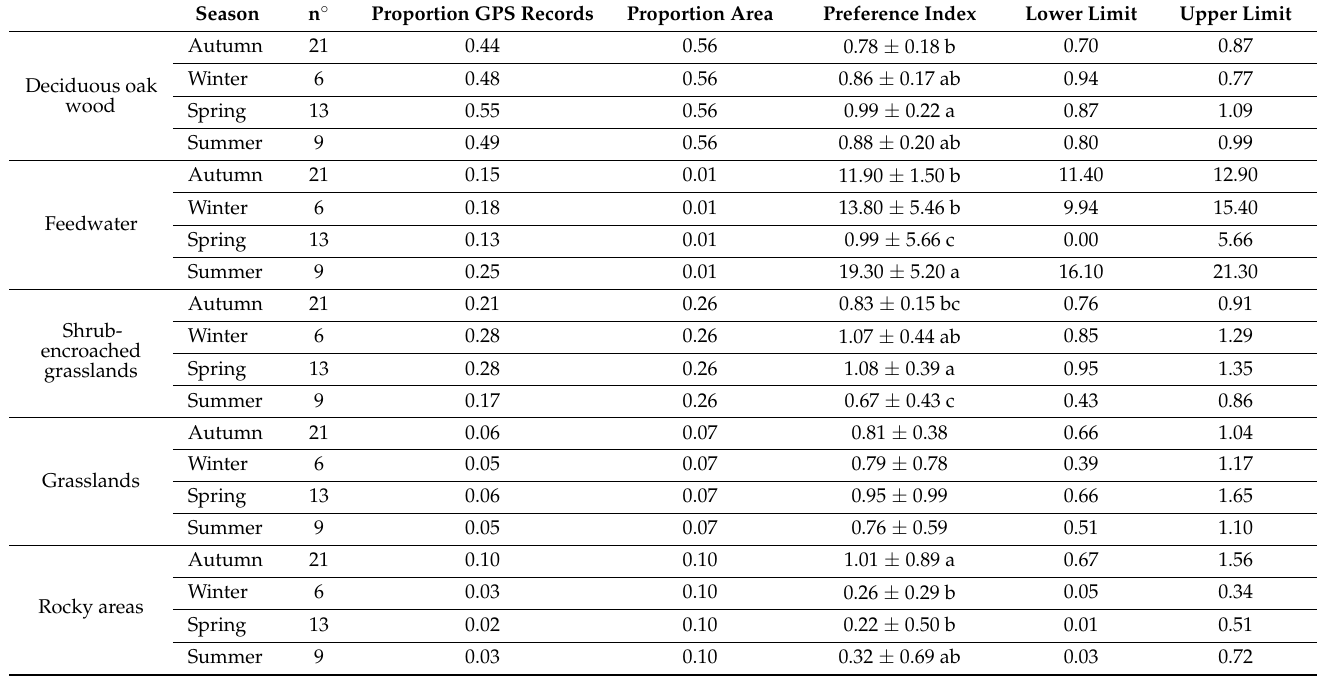
Table 5. Effects of seasons on proportion of GPS records and preference index (PI) (with a 95% confidence interval) for three structural physiognomic units of vegetation (VU), rocky areas and feedwater areas of grazing cattle under continuous grazing system in a Mediterranean silvopastoral area (median ± interquartile